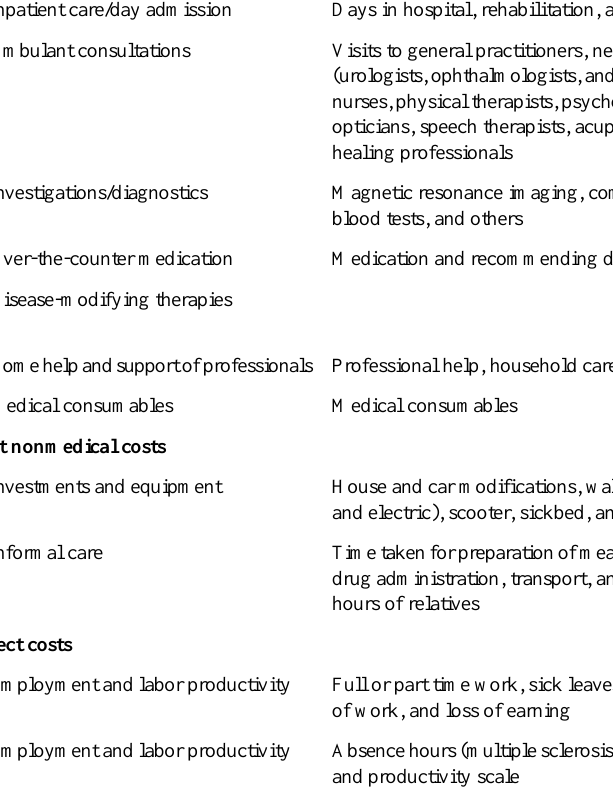
Table 2. Health resources and quantification. ValuationItemDomain Direct medical